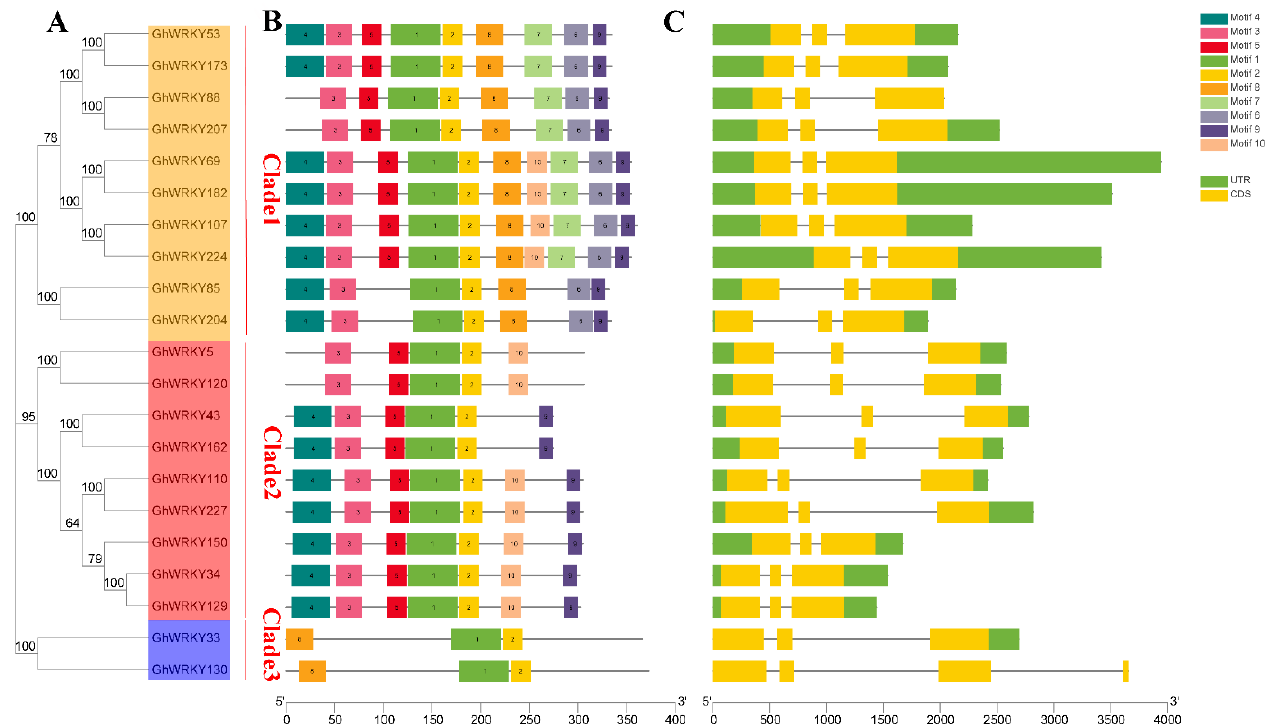
Figure 3. Phylogenetic relationship, motifs, and gene structures of group III WRKY genes or proteins in G. hirsutum L. ( A ) Phylogenetic analysis of putative amino acid sequences from the III WRKY group in G. hirsutum L. which was constructed by using MEGA X software with the neighbor-joining (NJ) method with 1000 bootstrap replicates; ( B ) Conserved motifs of group III WRKY proteins in G. hirsutum L. analyzed by the MEME; ( C ) The gene structures of group III WRKY genes in G. hirsutum L. which was performed by Gene Structure Display Server (GSDS). The CDSs, untranslated regions (UTRs) and introns are indicated with yellow rectangles, blue rectangles, and black lines, respectively.